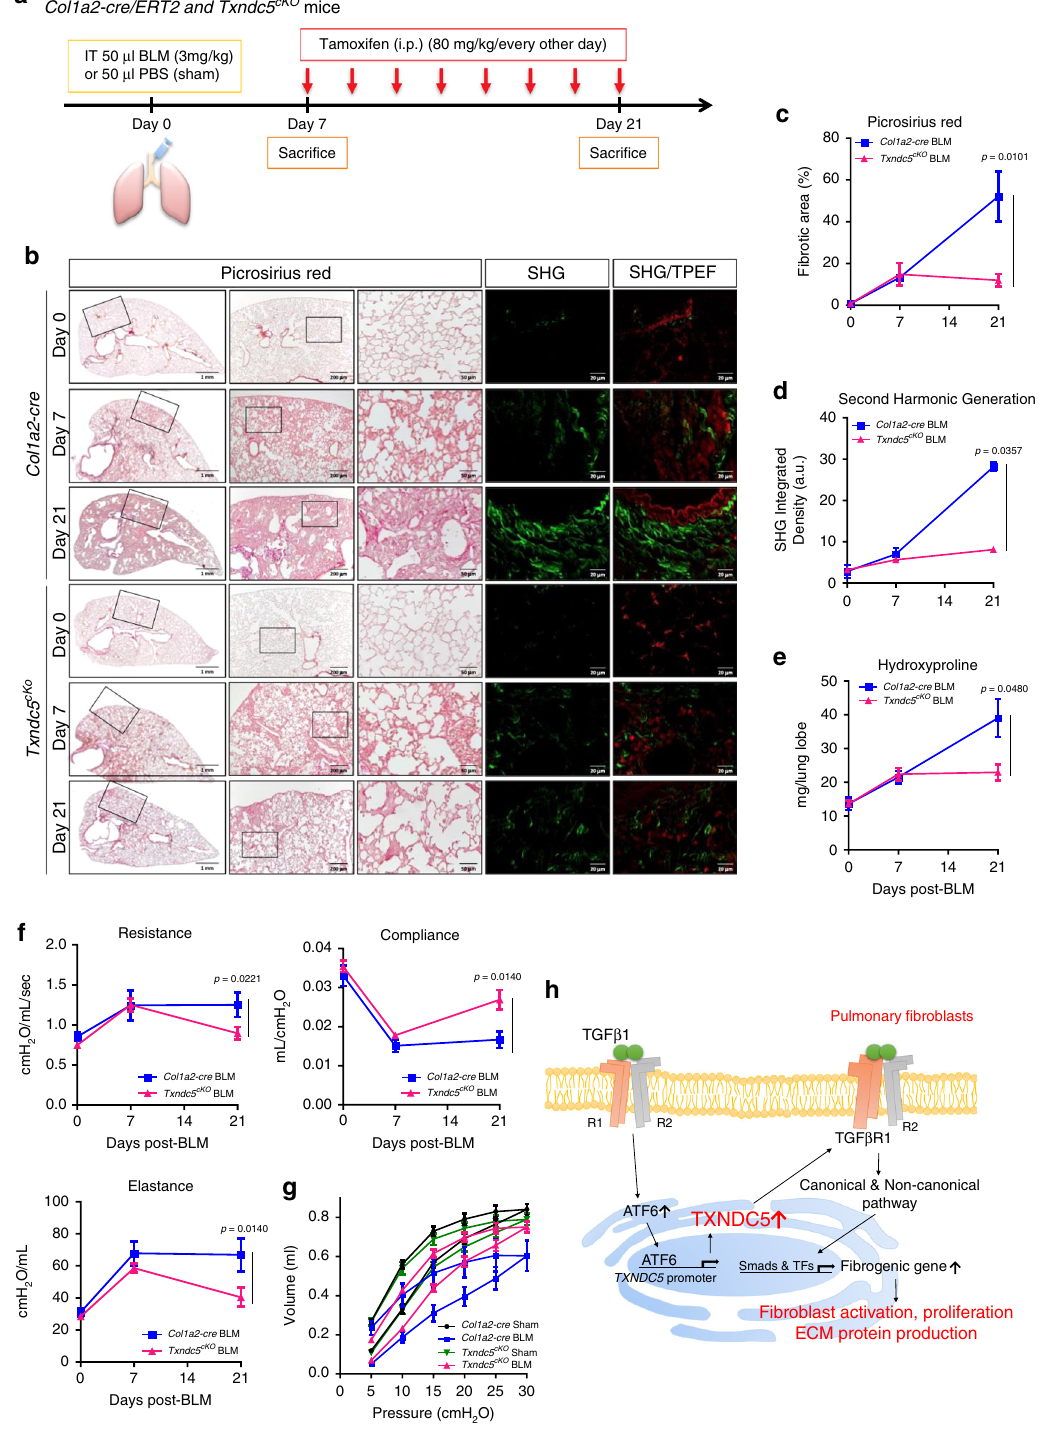
(Supplementary Fig. 13b), suggesting its fi broblast-speci fi c function that distinguishes TXNDC5 from other human PDIs. Global dele- tion of TXNDC5 did not result in developmental defects or pathological changes, which could be explained by the functional redundancy among the PDI family proteins and the observed cell type-restricted expression pattern of TXNDC5. Consistent with this suggestion, Txndc5 deletion did not lead to increased ER stress (Supplementary Fig. 14a – d) or apoptosis (Supplementary Figs. 14e, 16) in mouse lung tissue and fi